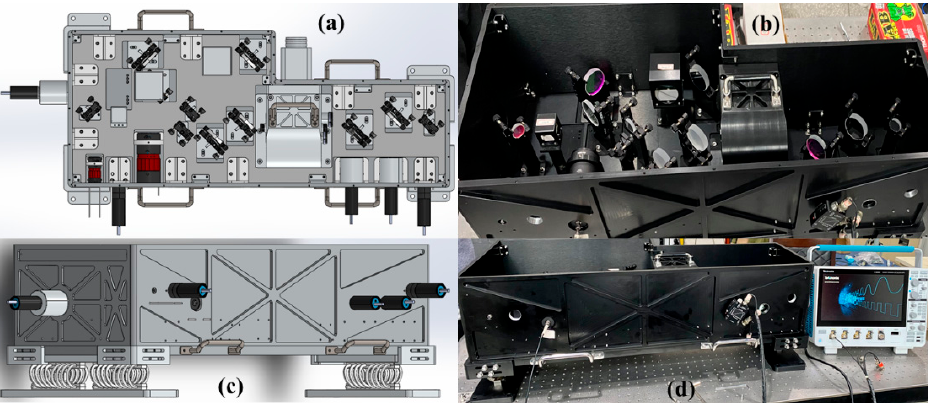
Figure 14. Schematic diagram of the receiver after structure optimization. ( a ), ( c ) Design sketches ( b ), ( d ) Solid drawings.